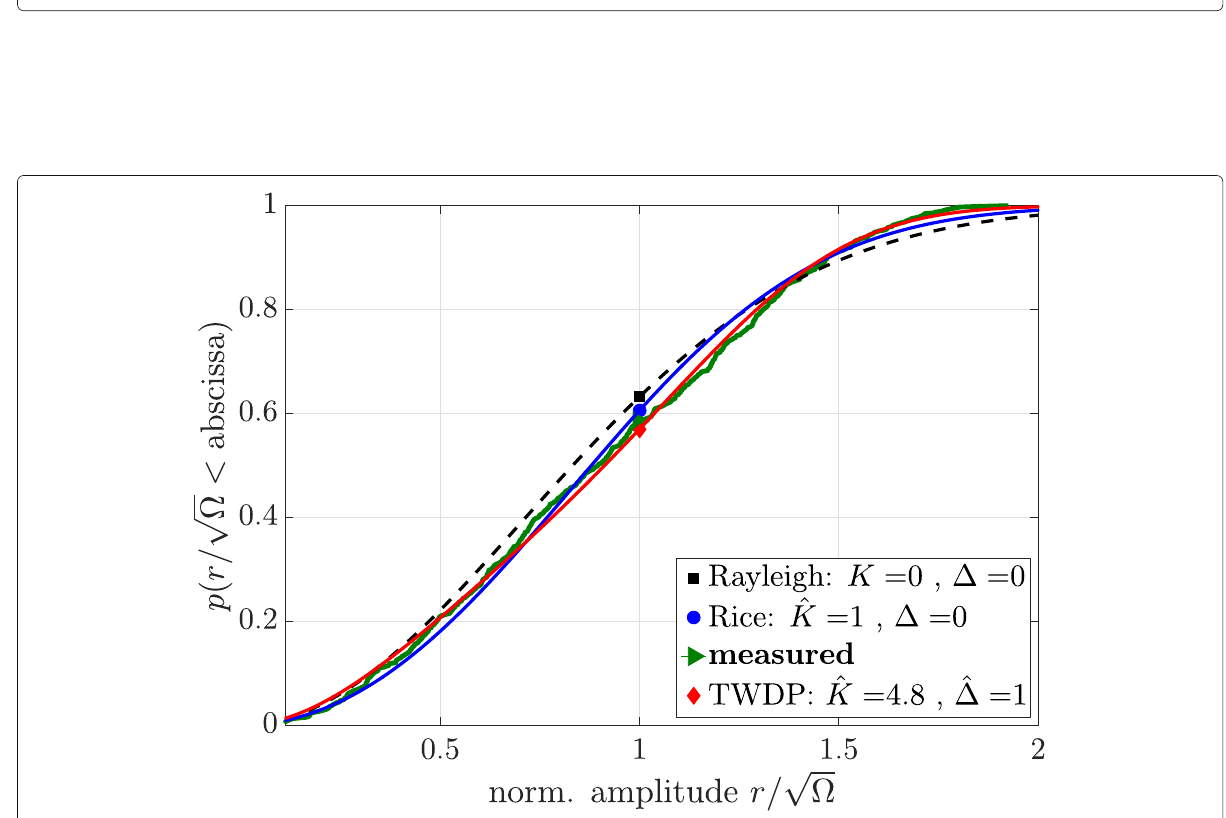
Fig. 15 Violin-plot of the CIR time-gated for the wall reflection. This figure shows a zoom-in of the gray-highlighted region in Fig. 14. In contrast to Fig. 14, the y -axis is in linear scale. Thereby, the violin plot indicates the distribution at each tap. The marker shows the mean value. The marker style codes best fitting distributions